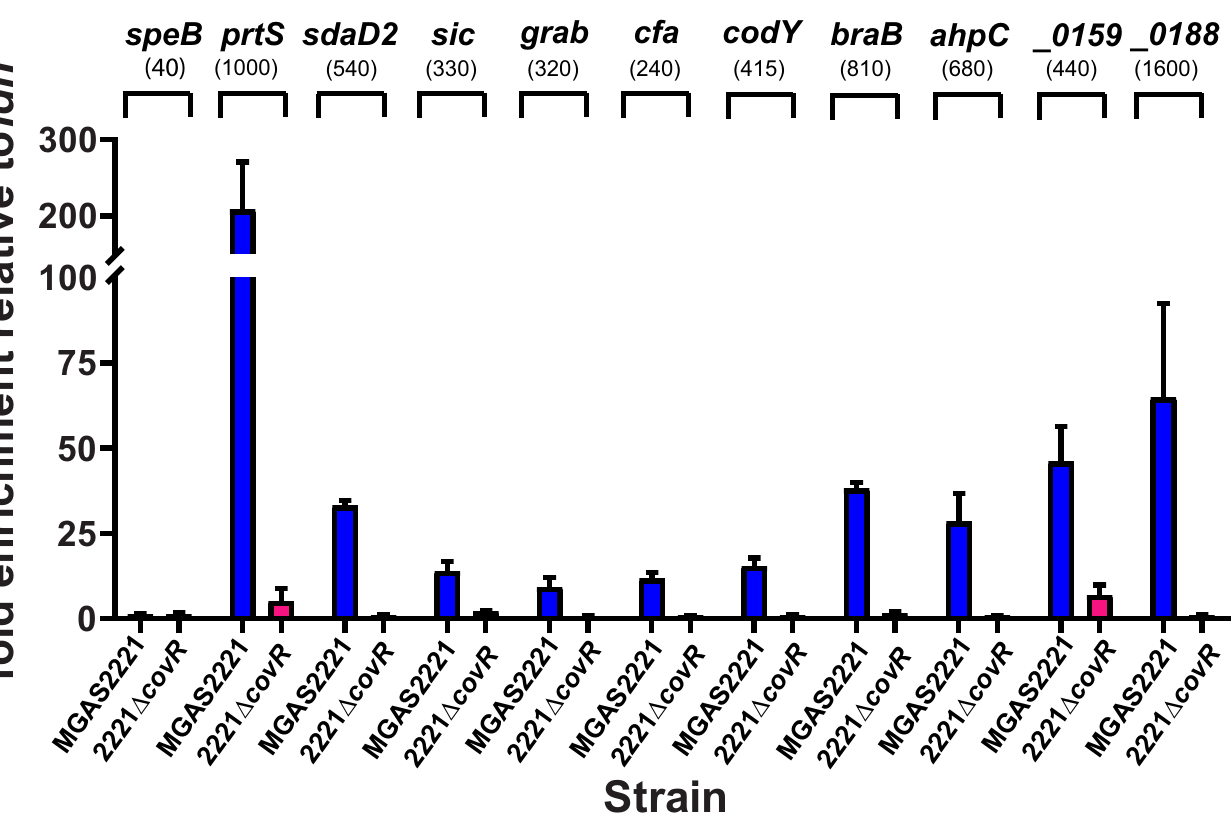
Fig 4. Validation of ChIP-seq binding data using SYBR qPCR. Graph depicts normalized enrichment of selected promoter DNA (labeled on top of graph) in ChIP samples obtained from denoted GAS strains as measured by SYBR qPCR. Measurements were done in duplicate with at least two biological replicates grown to mid-exponential phase with data shown being mean ± standard deviation. Given the lack of peaks in our ChIP-seq datasets in the speB region, SYBR primers for the speB promoter were chosen based on [14]. The numbers in brackets indicate the average RPKL in ChIP-seq experiment for comparison.